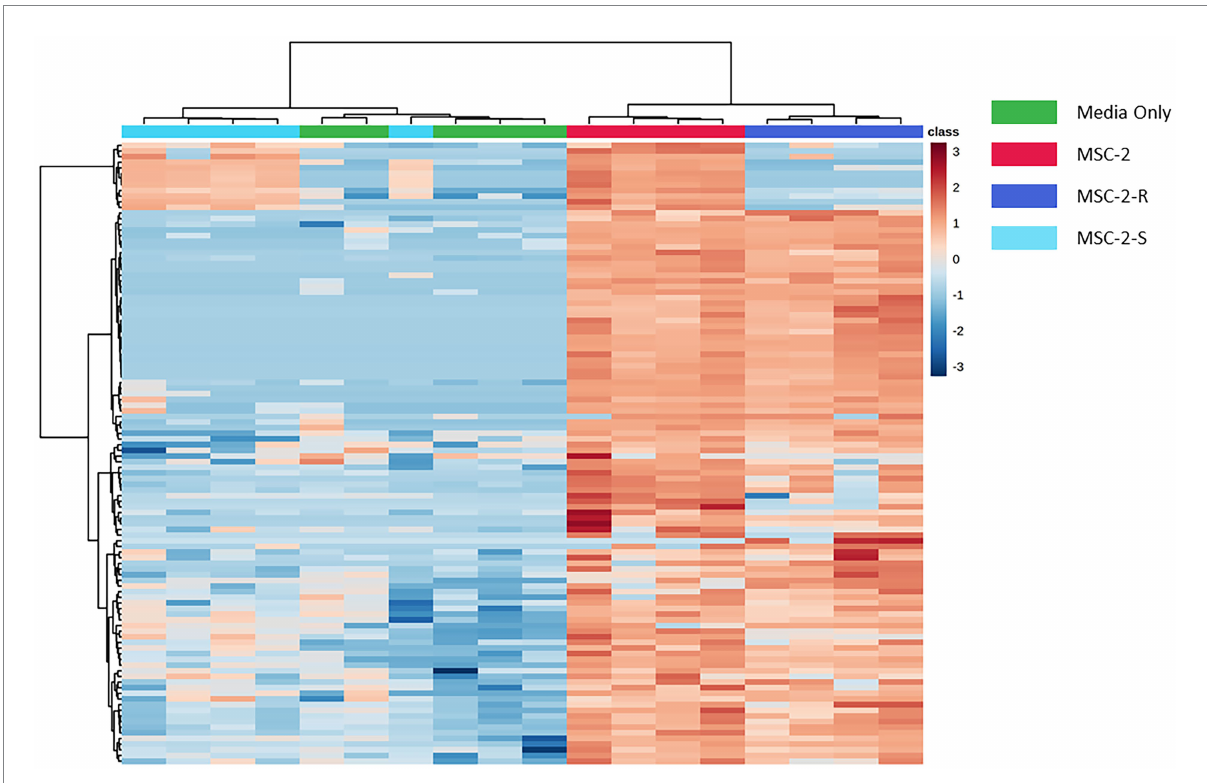
FIGURE 4 Heatmap of differentially abundant metabolites in MSC-2 communities, subsets and media controls. Both rows and columns are hierarchically clustered based on similarities in samples or metabolites, respectively, and color schemes indicate the sample type. Blue indicates that the metabolite is less abundant compared to all samples and red indicates that it is more abundant compared to all other samples. All metabolites included in the heatmap are statistically significant when comparing MSC-2-R to MSC-2 or when comparing MSC-2-S to